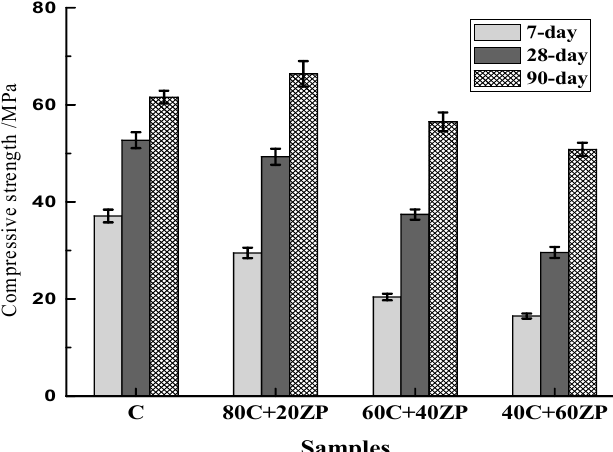
Figure 6. Compressive strengths of concrete samples.